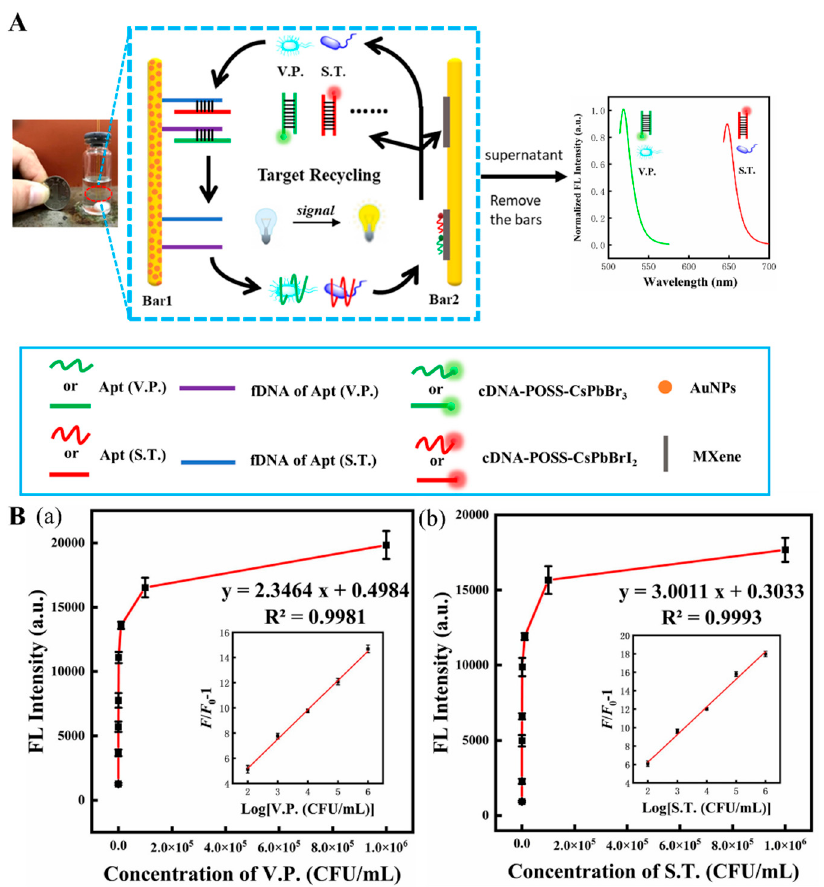
Figure 6. ( A ) Scheme of fluorescent aptasensor for dual-targets detection with its signal amplification strategy. ( B ) ( a , b ) the fluorescence intensity of the aptasensor in the presence of VP ( a ) and ST ( b ). Inset: linear range for this aptasensor for two corresponding foodborne pathogens. Reproduced with permission from Ref. [81].